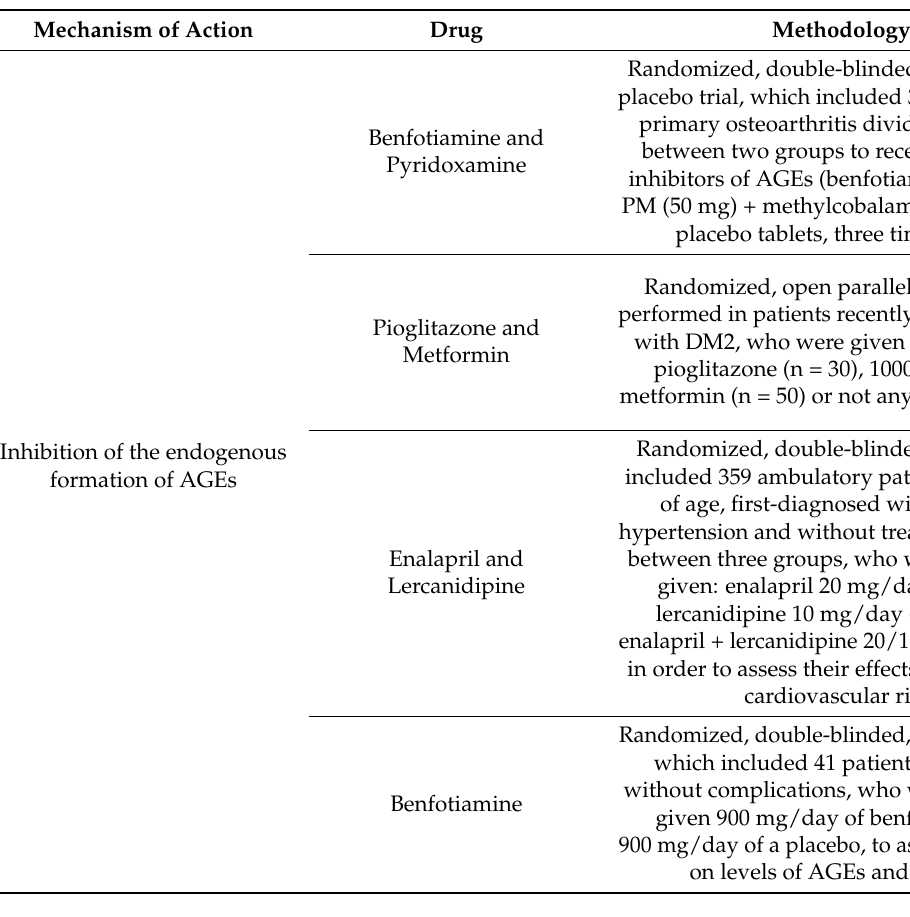
Table 1. Recent clinical evidence of therapeutic interventions in advanced glycation products and their